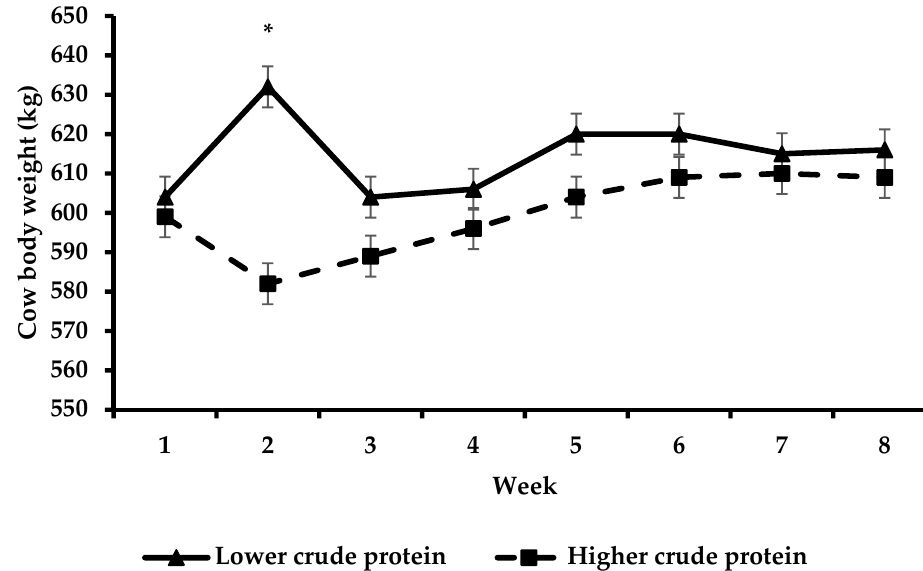
Figure 5. Body weight change over time with respect to lower crude protein and higher crude protein treatments. The effect of week was non-significant (asterisks (*) indicate a significant difference for week).